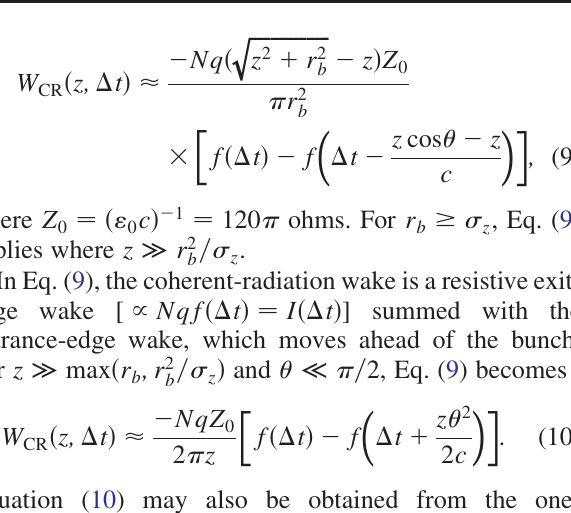
FIG. 1. (Color) Coherent-radiation wake W and Coulomb (or CR for a weak magnet that deflects a bunch LSC) wake W Coul through the angle (cid:1) ¼ 0 : 1 =(cid:2) . The bunch has a Gaussian longi- tudinal distribution, energy of 511 MeV, charge of 200 pC, rms length (cid:3) z ¼ 400 (cid:9) m , and radius r b ¼ 0 : 1 (cid:3) z . The head of the bunch is on the left, while a negative wake corresponds to energy loss. The coherent-radiation wake at a distance of 100 (cid:3) z down- stream of the magnet is plotted. For (cid:3) z (cid:5) z (cid:5) 10 5 (cid:3) z , the coherent-radiation wakes appear nearly